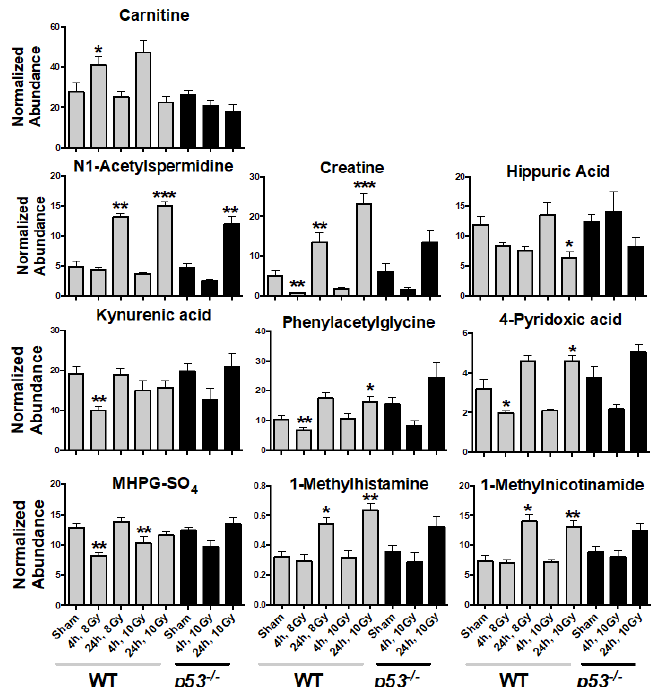
Figure 1. ( A ) Heatmaps generated by the machine-learning algorithm Random Forests of the top 100 ions at 4 and 24 h after 8 Gy total body irradiation for wild-type (WT) mice and at 4 and 24 h after 10